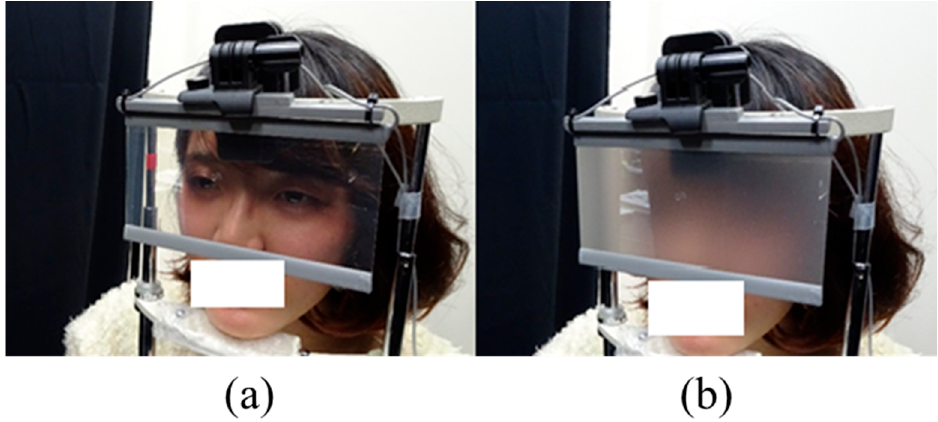
Figure 4. Liquid crystal shutter. Electronically controlled to open ( a ) and close ( b